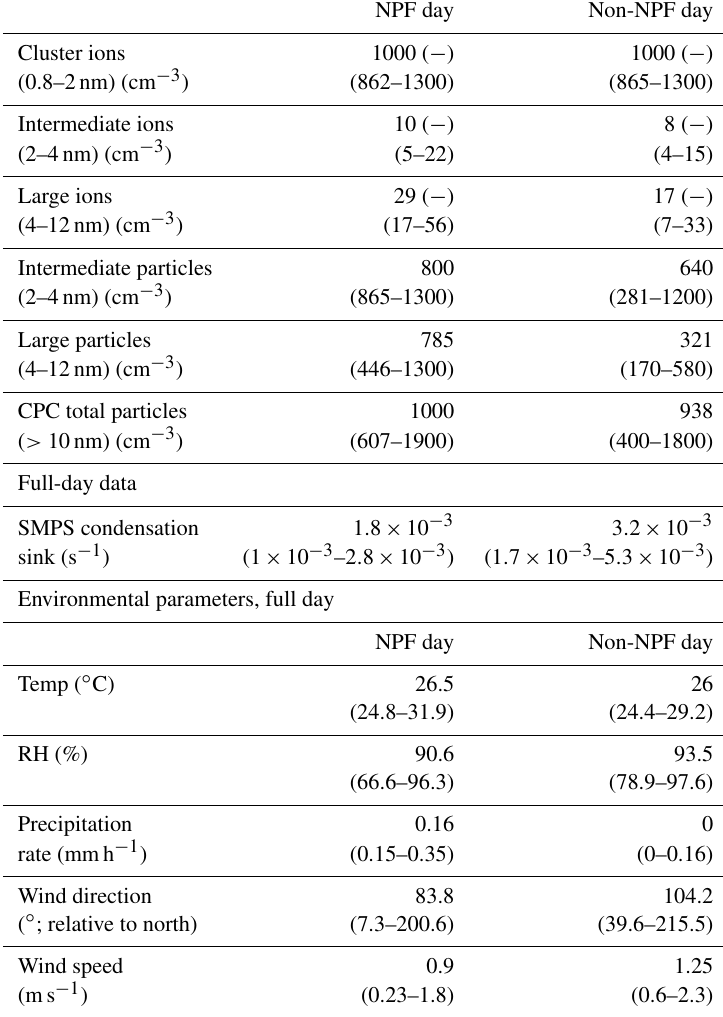
Table 3. The parameters from the pasture site for NPF days and nonevent days are shown. The values shown are the median total particle concentration measured by a CPC, the median neutral particle concentrations measured by the NAIS in two size ranges (2–4 and 4–12nm), and the median negative ion concentrations from the NAIS in three size ranges (0.8–2, 2–4, and 4–12nm). The values are calculated for the time window 08:00–12:00, which is when the NPF events take place. The numbers in brackets represent the 25th and 75th percentiles. The second part of the table includes median numbers of environmental parameters for the whole day: temperature, RH, precipitation, and wind direction for NPF and nonevent